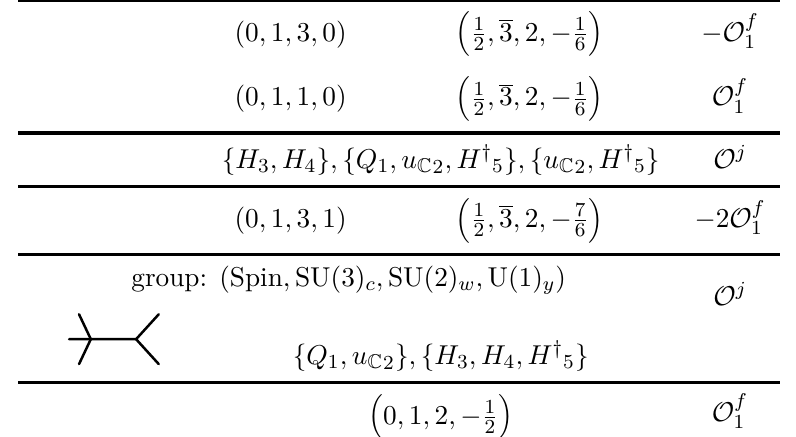
Table 23. UV resonance of topology dim6-5. “*” in front of each row indicates topologies with nonrenormalizable vertices. The UV resonances colored in gray are eliminated by UV